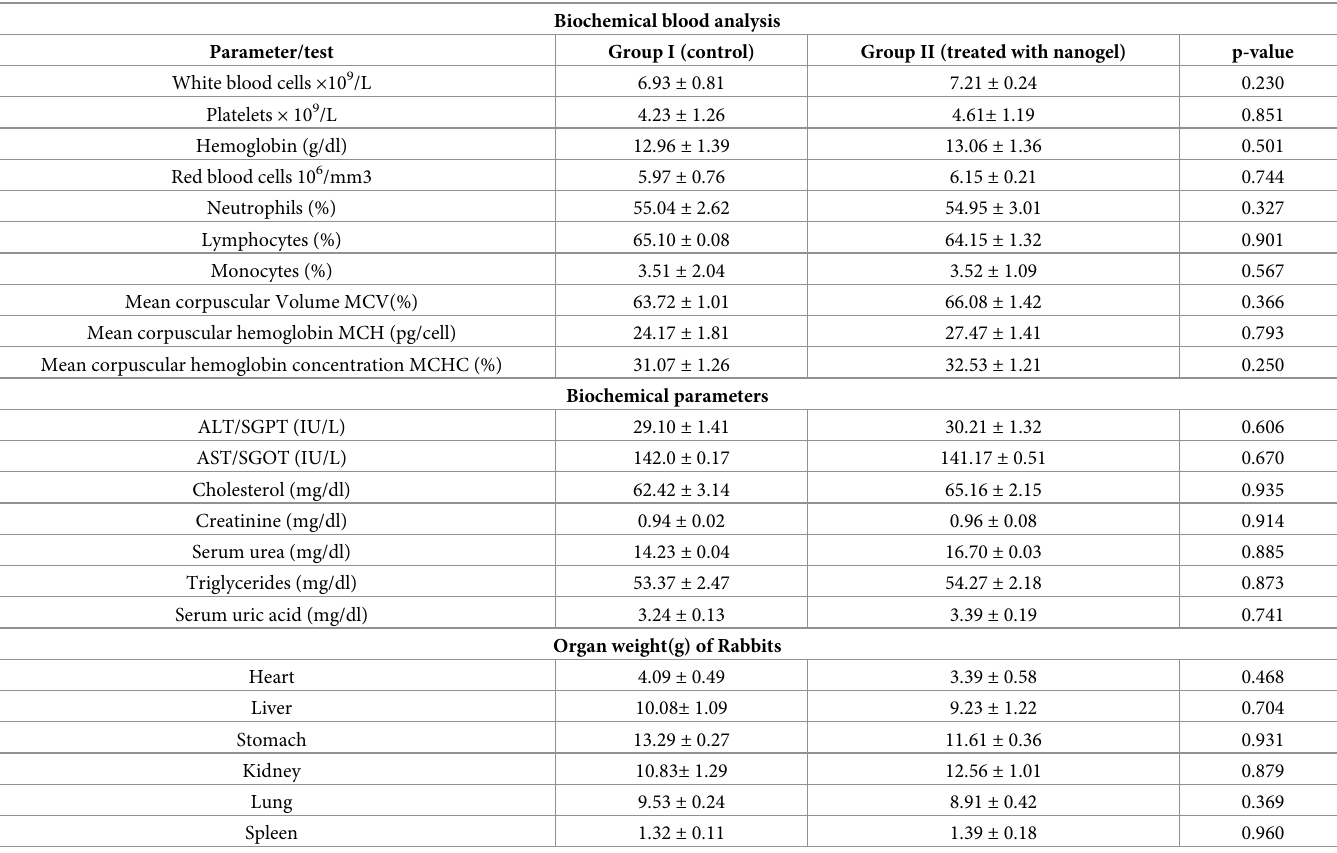
Table 6. Hematology, biochemical parameters and consequences of orally administered β CD /PVP-co-poly (AMPS) nanogels on organ weight (g) of rabbits. Biochemical blood